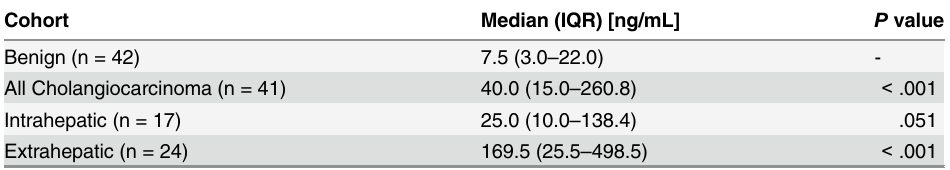
Table 2. Concentration of biliary CEACAM6 by immunosorbant assay.